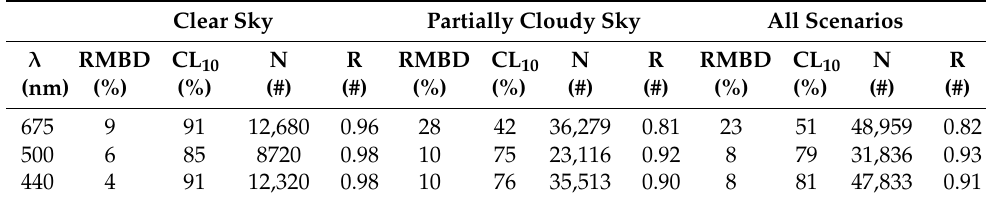
Table 4. Comparison between AERONET almucantar and SONA estimated radiances from 12 February to 31 October 2020. N represents the number of samples for each scenario and R is the correlation factor. Clear Sky Partially Cloudy Sky All